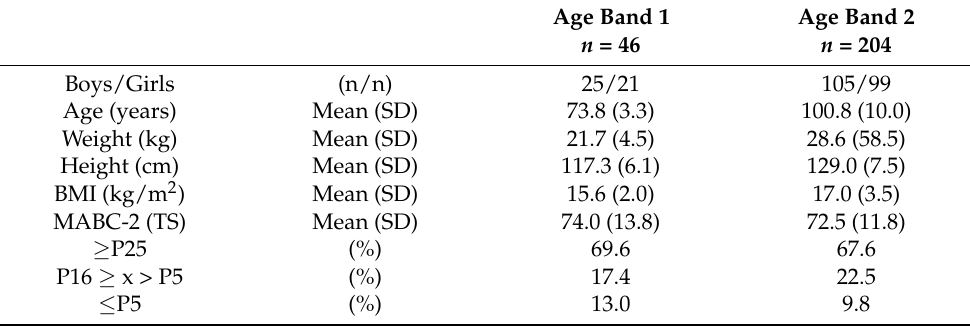
Figure 1. Selection of children and tests administered. Table 1. Demographic data of the children included in the study per age band.